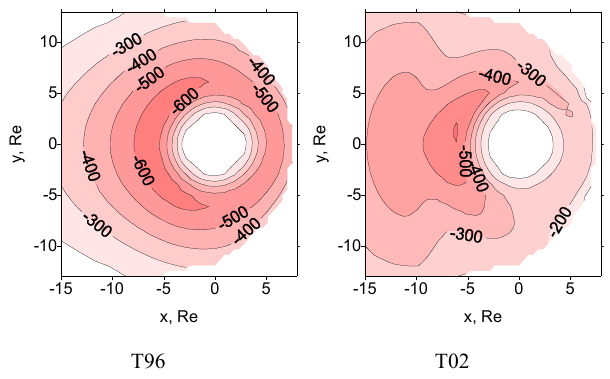
Fig. 5. Surface density of the azimuthal electric current in two mod- els by Figure 5. Surface density of the azimuthal electric current in two models by Tsyganenko.